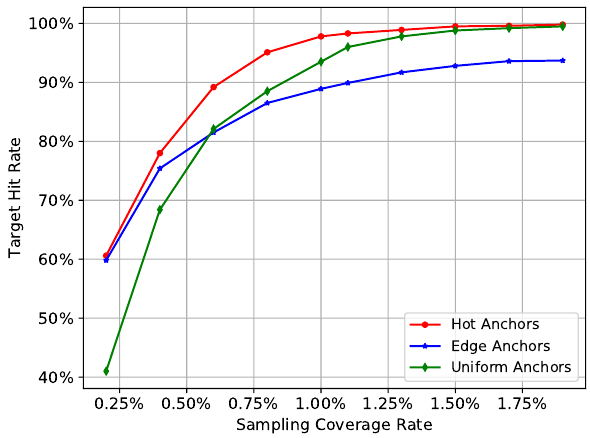
Figure 4. The hit rate curves of three sampling methods. Hit distance threshold d 0 is